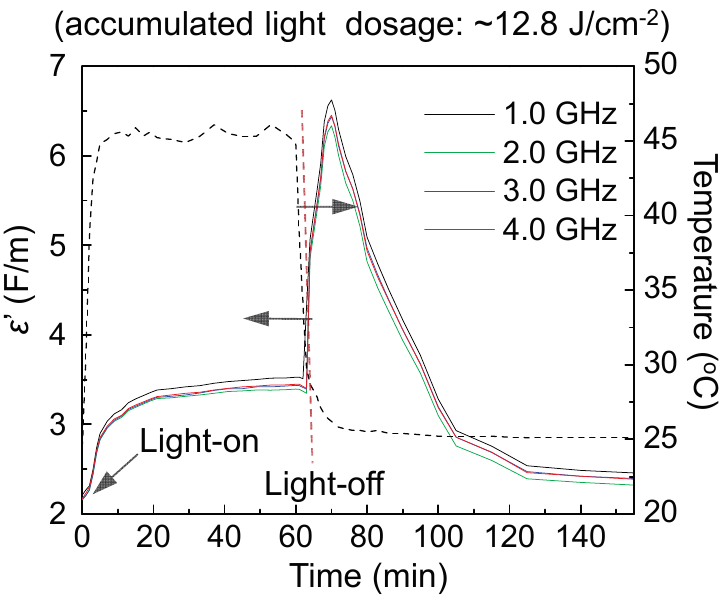
Figure 6. Time-dependent relative dielectric constant ( ε r ′ ) profiles of trilayered sample 3 – 1 at the frequency range of 1.0 ‒ 4.0 GHz under illumination using a LED white light, showing large photoswitchable amplification of ε r ′ at the light-off